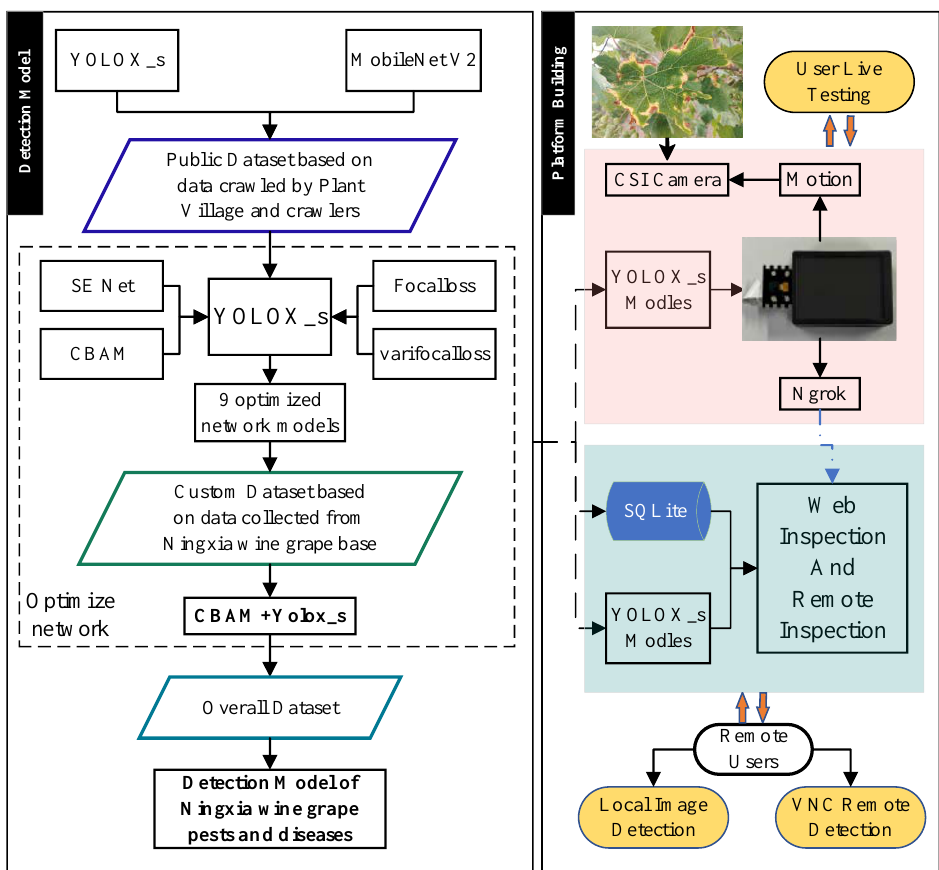
Figure 1. The technical route of network optimization and testing platform construction.